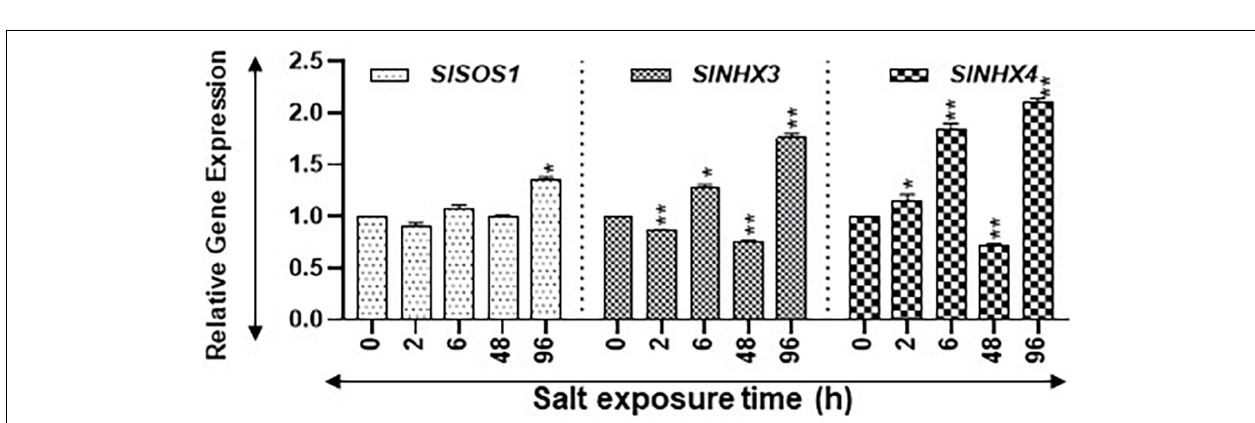
FIGURE 8 | Expression levels of salt stress-related marker genes. Quantitative PCR was used to determine the steady state levels of transcripts of salt-induced marker genes SlSOS1 , SlNHX3 , and SlNHX4 . SlUBI3 and SlTIP41 were used as reference genes. Other details are the same as in Figure 1 .